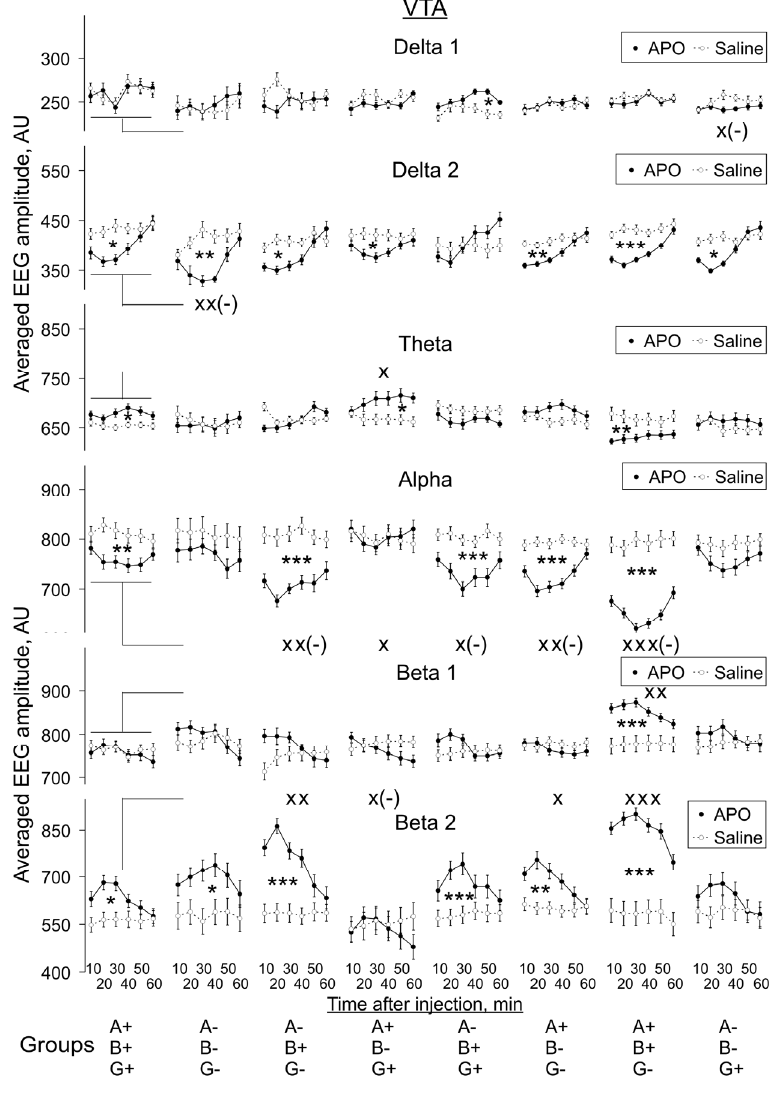
Figure 7. Evolution of apomorphine (APO, 1.0 mg/kg, s.c.) vs. saline effects in “classical” frequency bands of 12 s fragments of EEG from VTA averaged for consecutive 10 min intervals (abscissa) in knockout mice of different types. Ordinate is the averaged absolute values of EEG amplitudes in each of the “classical” bands, in arbitrary units (vertical lines are ± 1 SEM), obtained in experiments with saline and APO (grey and black lines, respectively) in each group. Differences between baseline EEGs in knockout and wild-type mice were used to normalise the APO effects in knockout groups to those in control. Symbols * and x denote the significant differences of APO vs. saline and knockout mice vs. wild-type control, respectively (one, two and three symbols denote p < 0.05, <0.01 and 0.001, respectively). Symbol x(-) denotes the significant enhancement of the APO suppressive effect, for clarity.